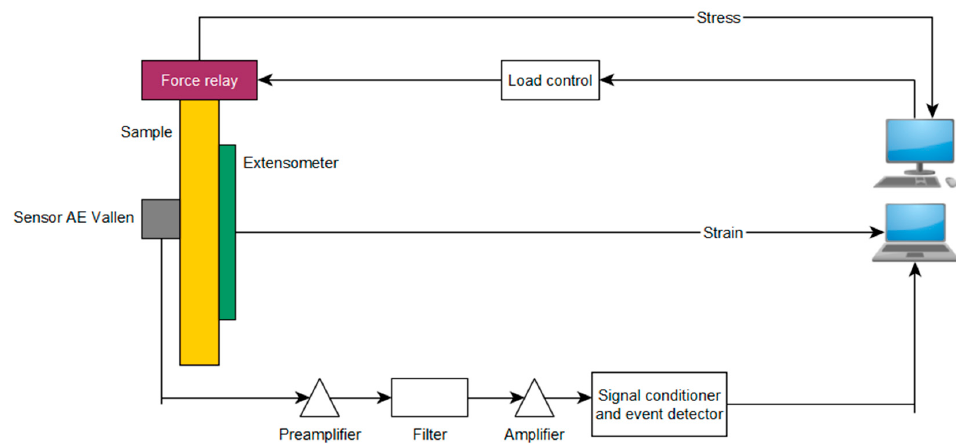
Figure 2. Diagram of measuring station.